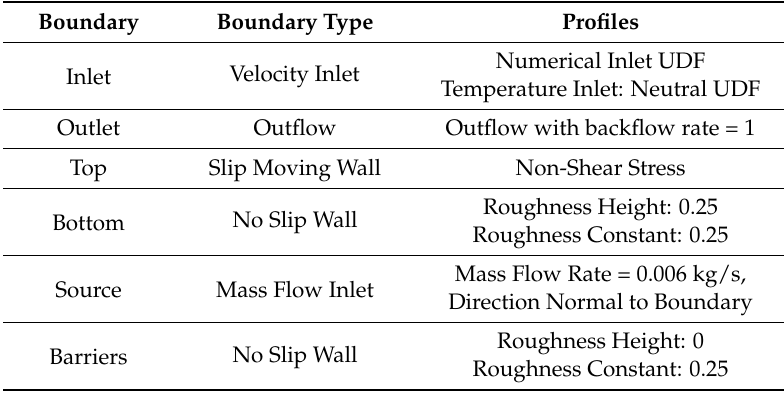
Table 1. Boundary conditions for neutral condition.